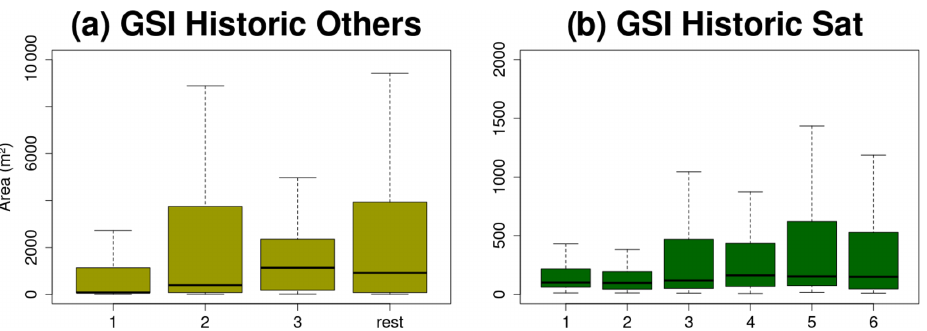
Figure 8. Landslide area boxplots per SA classes. Numbers on the x axis are the SA classes of the EV map. The horizontal solid line inside each box indicates the median value.